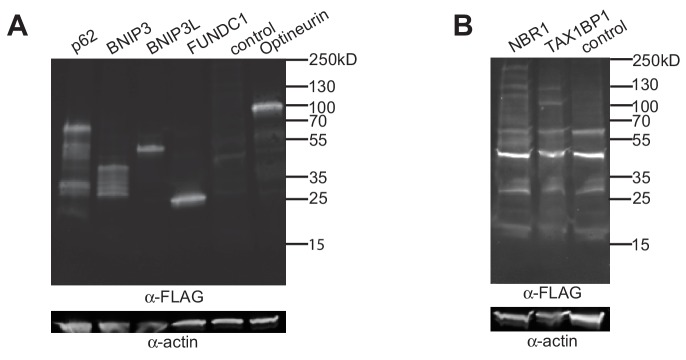
Epitope tagged autophagy receptors were expressed in RAW macrophages.(A and B) Immunoblot showing expression of FLAG-tagged autophagy receptors in RAW macrophages. RAW macrophages were transduced with FLAG-tagged autophagy receptor constructs and cell lysates probed with α-FLAG and α-actin antisera. Immunoblots were imaged with a short (A) or a long (B) exposure time to better detect the higher molecular weight autophagy receptors (Tumbarello et al., 2015; Ito et al., 2015).